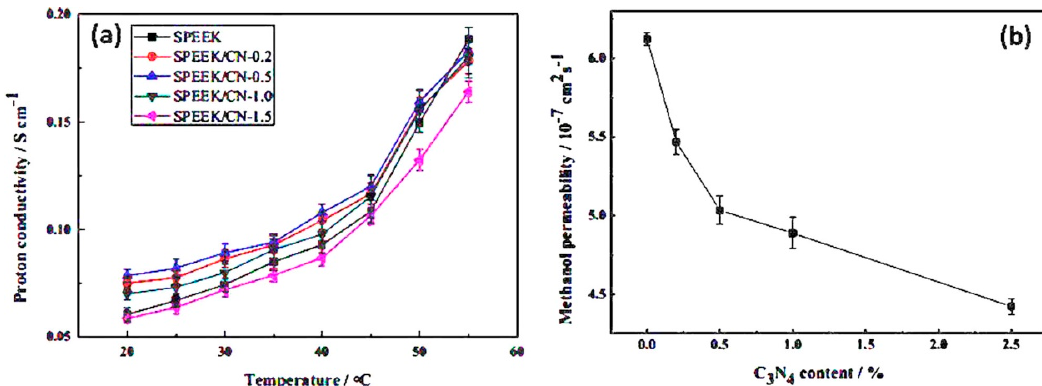
Figure 17. Proton conductivity of H 3 PO 4 ‐ doped ABPBI and ABPBI/AM ‐ POSS composite membranes at an anhydrous atmosphere. Reproduced with permission from [119]. Copyright Elsevier, 2016.